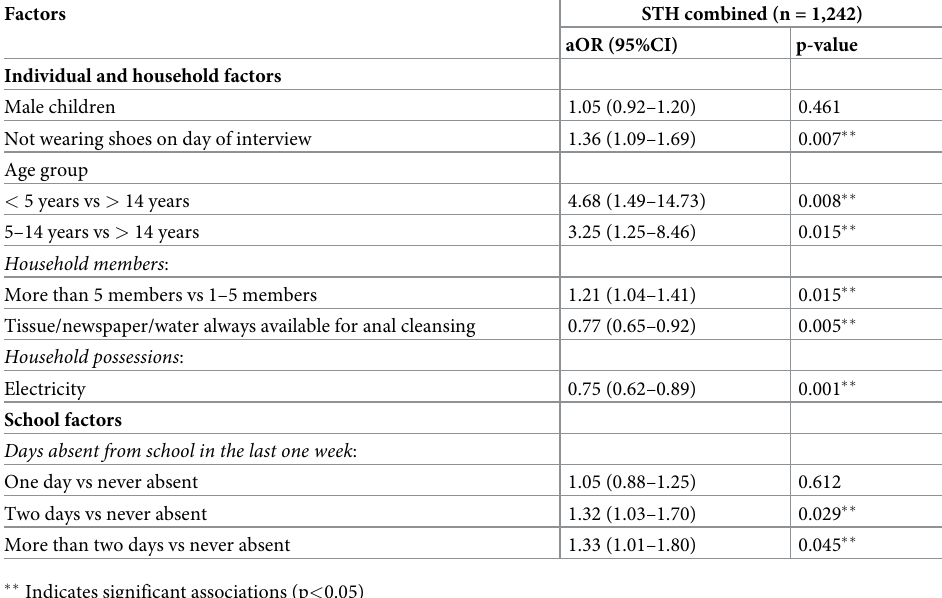
Table 9. Multivariable associations between WASH conditions and STH combined infections among school chil- dren in Kenya after five rounds of MDA.